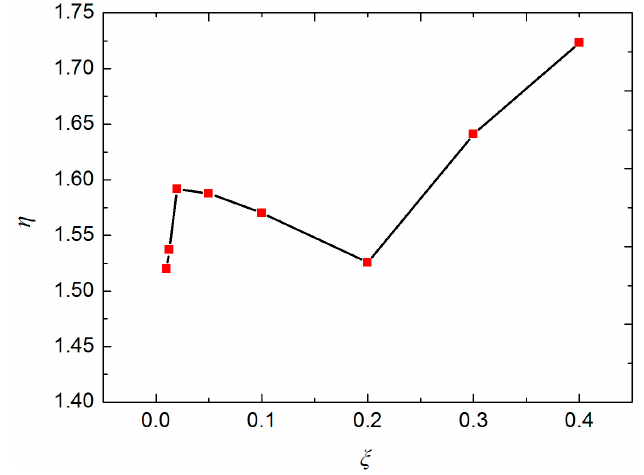
Figure 11. The FLAC results of η crest (where K = 0.5).